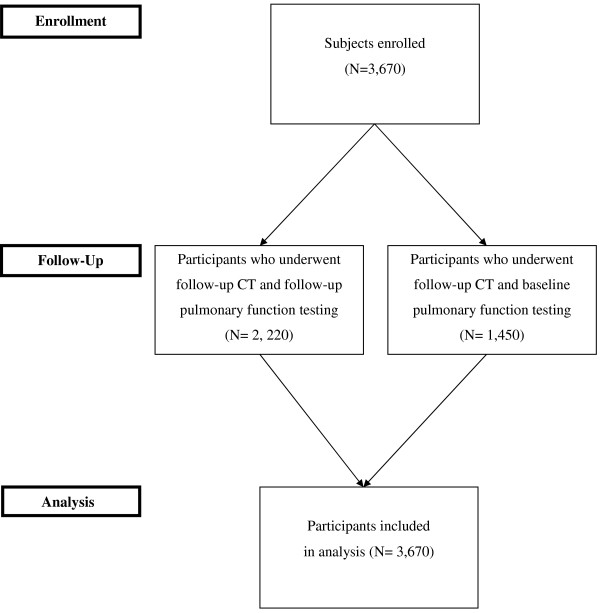
Flowchart of included subjects.